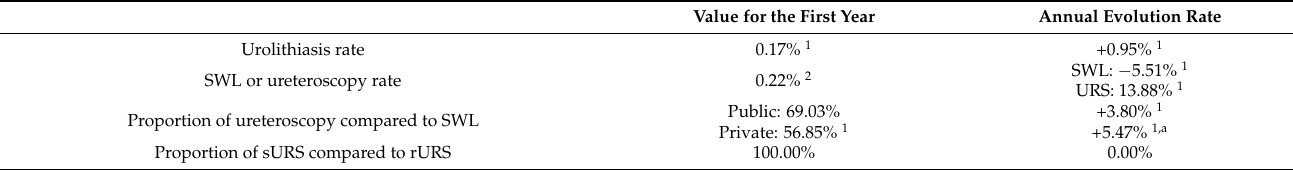
Table A1. Values and sources of the input